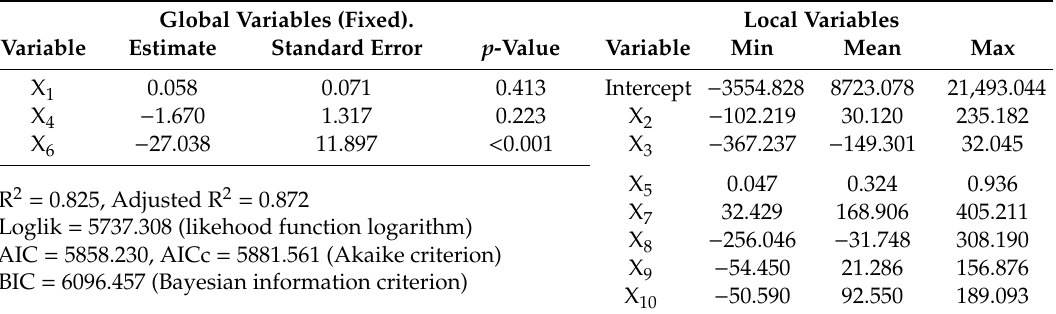
Table 6. Results of the MGWR1 (mixed geographically weighted regression) model parameter estimation.